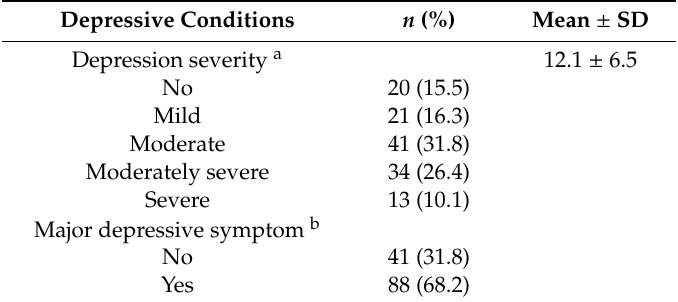
Table 3. Depressive symptoms among middle- and old-aged homeless